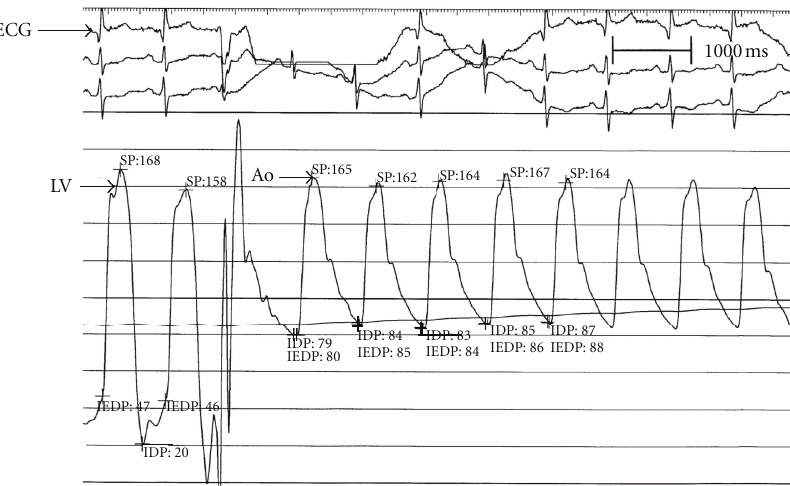
Figure 4: Pressure tracings show a sharp rise in LV outflow gradient that follows the pause associated with PVC. A dynamic obstruction leads to a concomitant fall in aortic pressure and a disproportionate (46 to 130 mmHg) increase in gradient. This phenomenon, known as the Brockenbrough-Braunwald-Morrow sign, is part of the classical description of hypertrophic obstructive cardiomyopathy. Ao: aorta; ECG: electrocardiogram; LV: left ventricle; PVC: premature ventricular